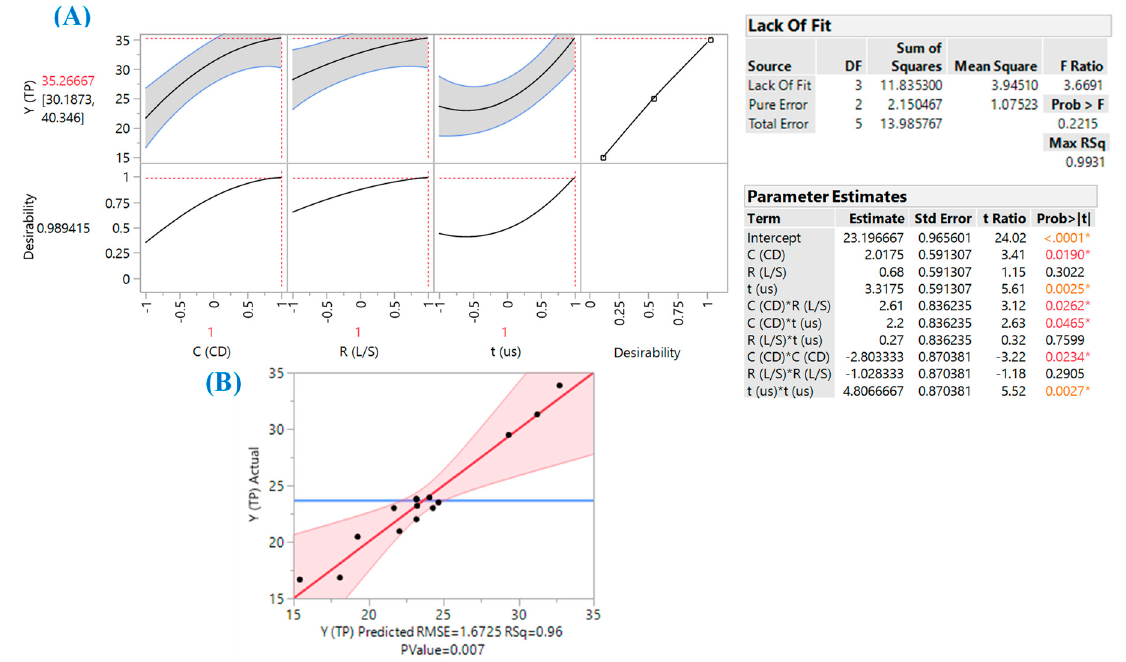
Figure 2. Data on the desirability function ( A ) and correlation between actual and predicted values ( B ). Inset tables show statistical information regarding the model derived from the implementation of response surface methodology. Asterisk denotes statistically significant values. Table 2. The experimental design used to implement response surface methodology, displaying all points considered and the measured and predicted values of the